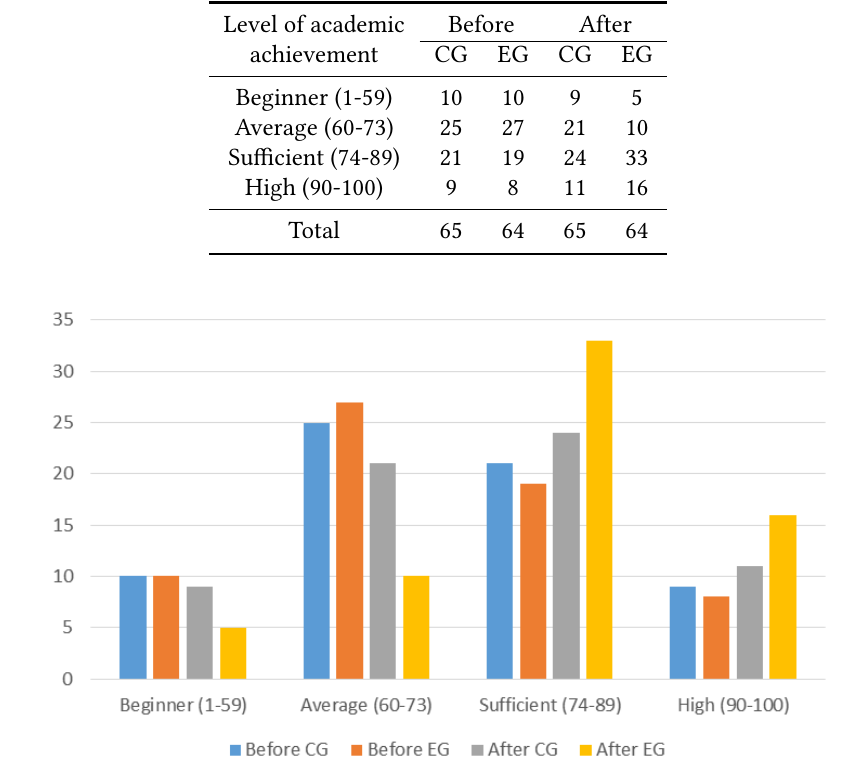
Table 1 Comparative distribution of students from the CG and the EG by the level of educational achievements in the fundamentals of programming at the beginning and end of the pedagogical experiment.